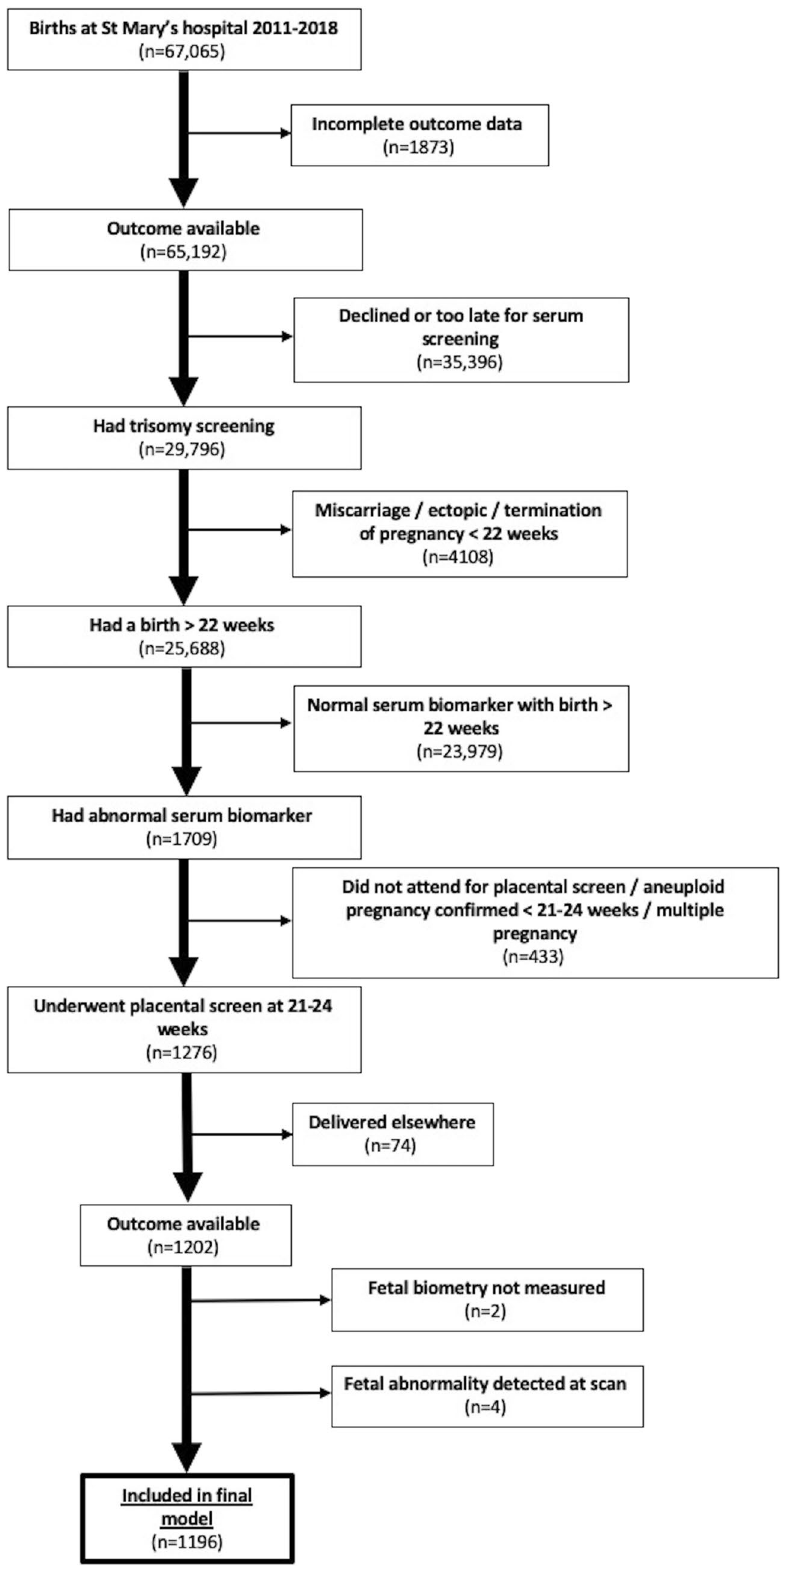
Figure 1. Consort